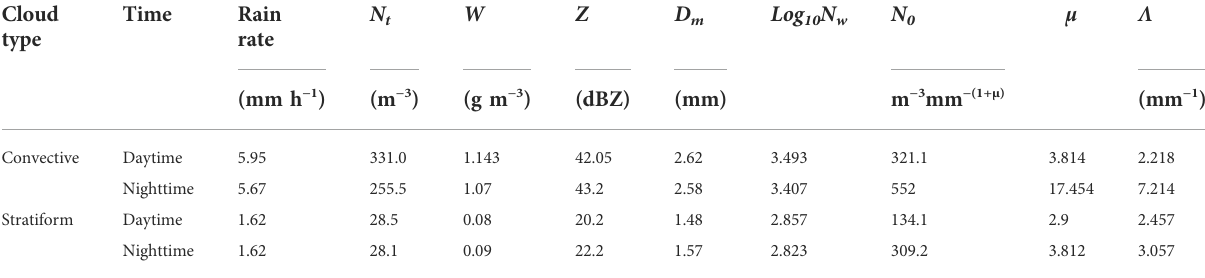
TABLE 4 Integral rain parameters obtained from the average raindrop size distribution for the daytime and nighttime precipitation